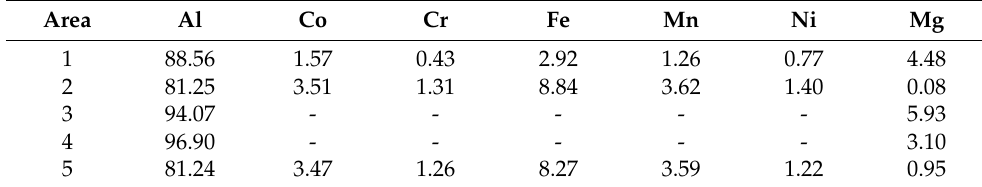
Table 2. The chemical compositions of the various areas in the Al 13 Fe 4 second-phase precipitation which are indicated in Figure 3d (at.